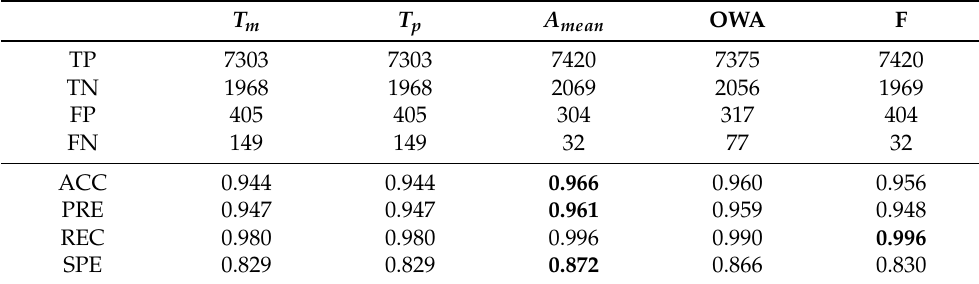
Table 1. Confusion and classification evaluation metrics by the standard fuzzy inference system with aggregations from examples 2 and 3.